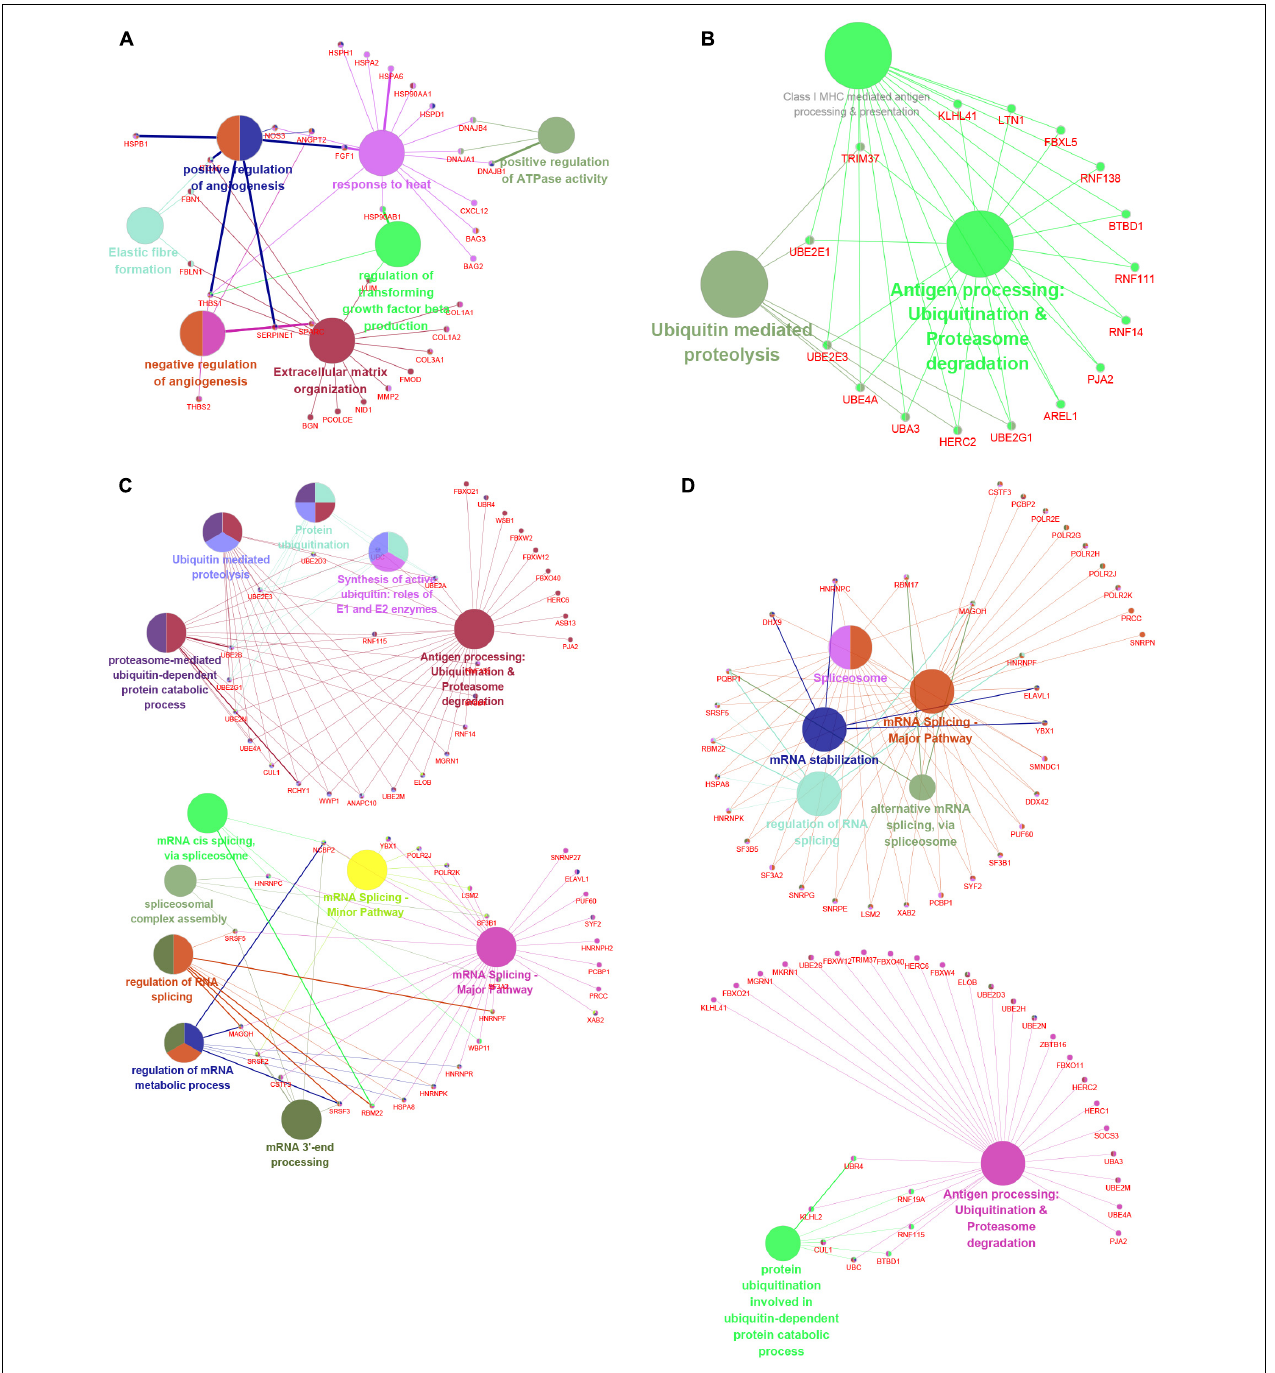
FIGURE 9 | Functional annotation of hub networks in different clusters in MI. (A–D) We predicted potential functions of hub networks based on DEGs in MI compared with non-failing controls (A) , in cluster 1 MI compared with cluster 2 MI samples (B) , in cluster 1 MI compared with cluster 3 MI samples (C) , and in cluster 2 MI compared with cluster 3 MI samples (D)